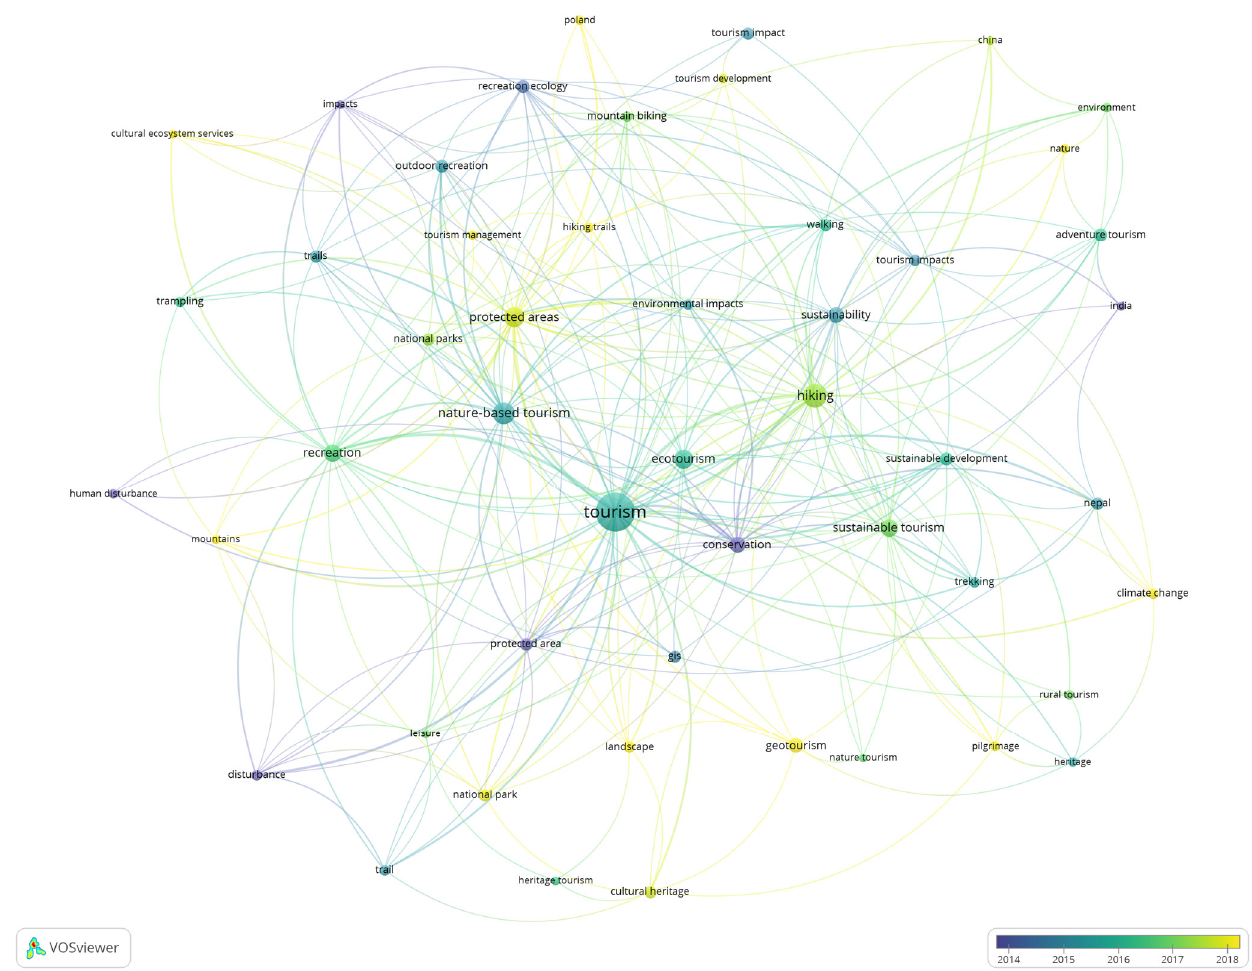
Figure 5. Visualization of networks with common keywords .